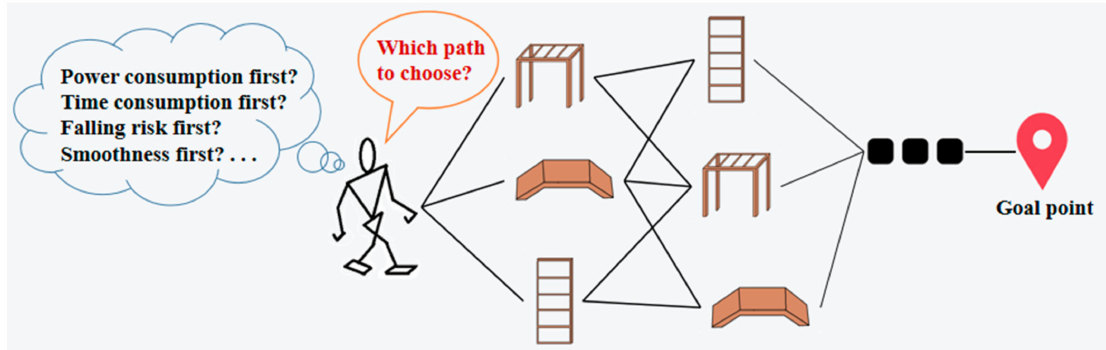
Figure 3. Multi-objective path